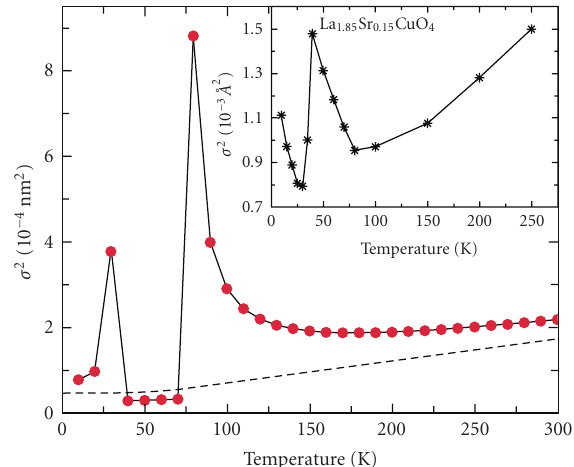
Figure 16: Calculated temperature dependence of the mean square Cu-O displacement σ 2 ( T ). T ∗ is defined as the temperature where the first divergence in σ 2 ( T ) appears (in this example at T = 100 K). The lower temperature divergence occurs at or below T c depending on the pairing symmetry as explained in the text. The inset shows the experimental results obtained in